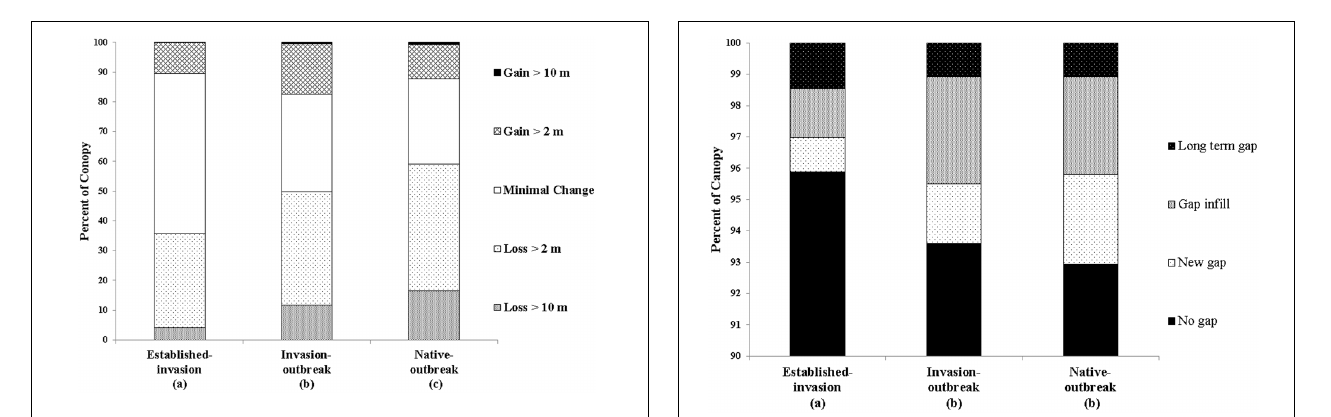
FIGURE 6 | Change in gap dynamics between 2007 and 2016. Different letters below the x -axis indicate statistically significant differences between forest types ( Table 1 ).